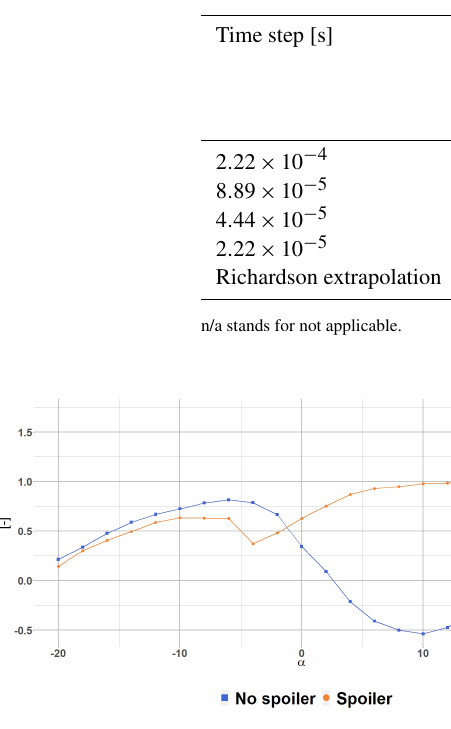
Figure 7. Lift coefficient polar for the radial position R6 ( r 13%). The blue square (blue (cid:4) ) shows the C L for the no spoiler case, and the orange dot (orange • ) shows the C L for the spoiler case.